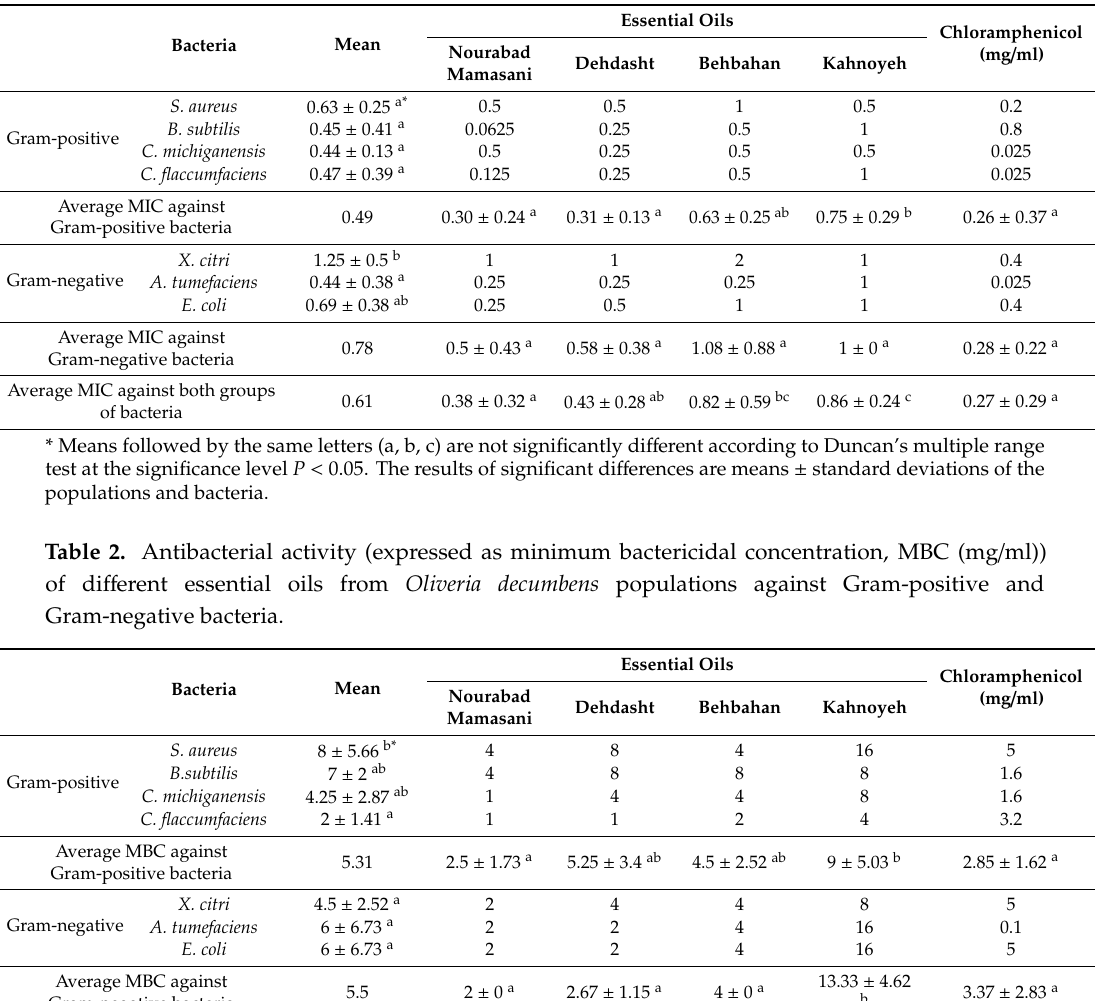
Table 1. Antibacterial activity (expressed as minimum inhibitory concentration, MIC (mg / ml)) of di ff erent essential oils from Oliveria decumbens populations against Gram-positive and Gram-negative bacteria.